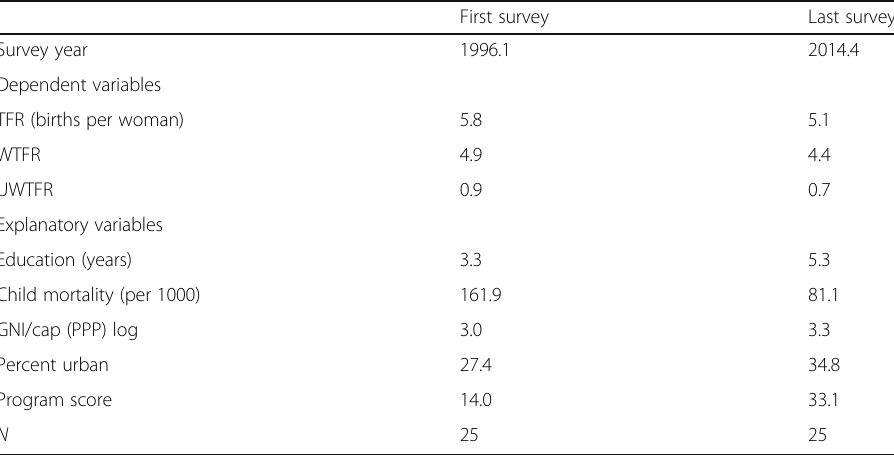
Table 1 Mean values (unweighted) of the dependent and explanatory variables at the time of the first and last DHS survey, 25 countries in sub-Saharan Countries First survey Last survey